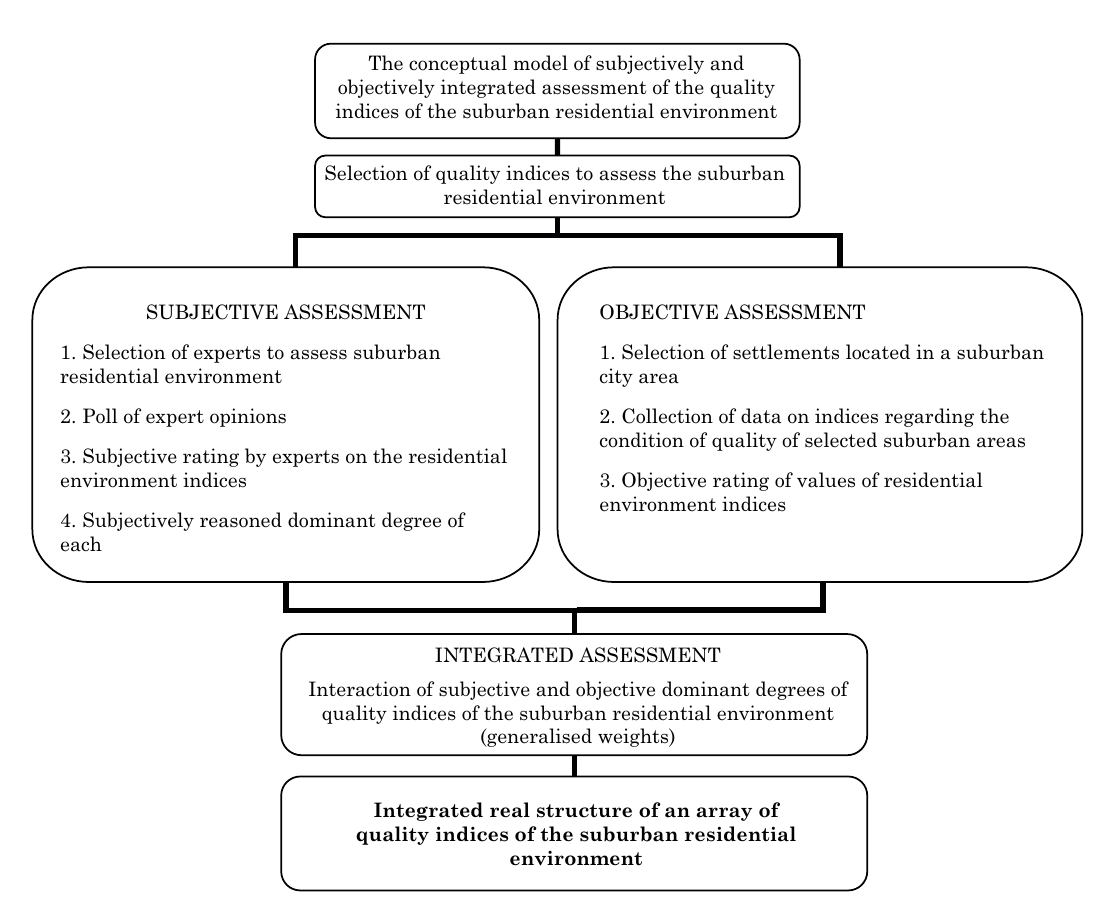
Fig. 1. The conceptual model of subjectively and objectively integrated assessment of quality indices of